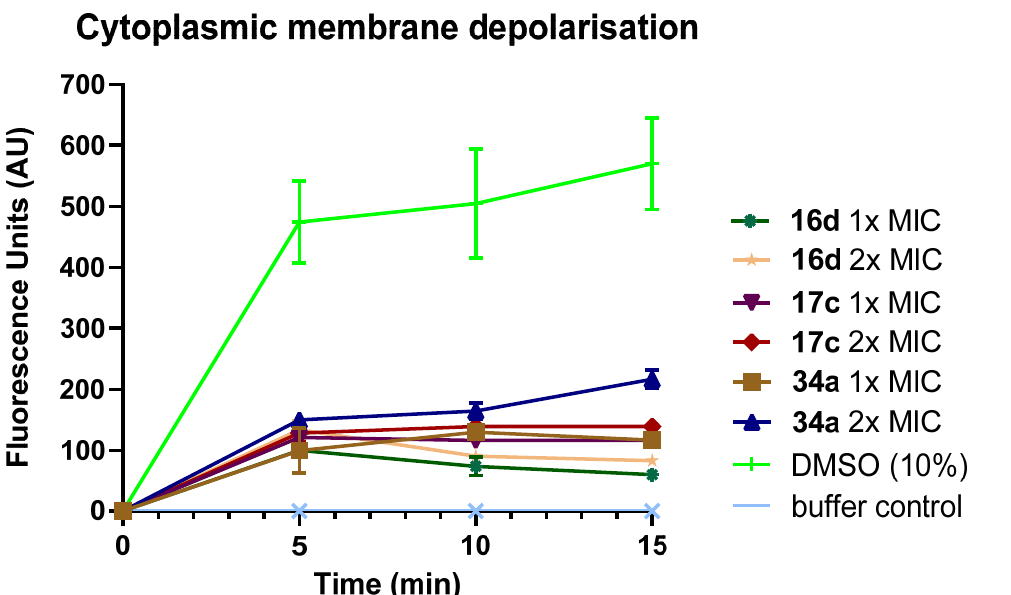
Figure 6. S. aureus cytoplasmic membrane depolarisation induced by peptidomimetics 16d , 17c and 34a at 1 × MIC and 2 × MIC. As a positive control, 10% DMSO was used. Error bars represent the standard error of triplicates ( n = 3). Table 2. IC 50 value of peptidomimetics against MRC-5 normal human lung fibroblasts and their therapeutic indices with respect to S. aureus and E. coli